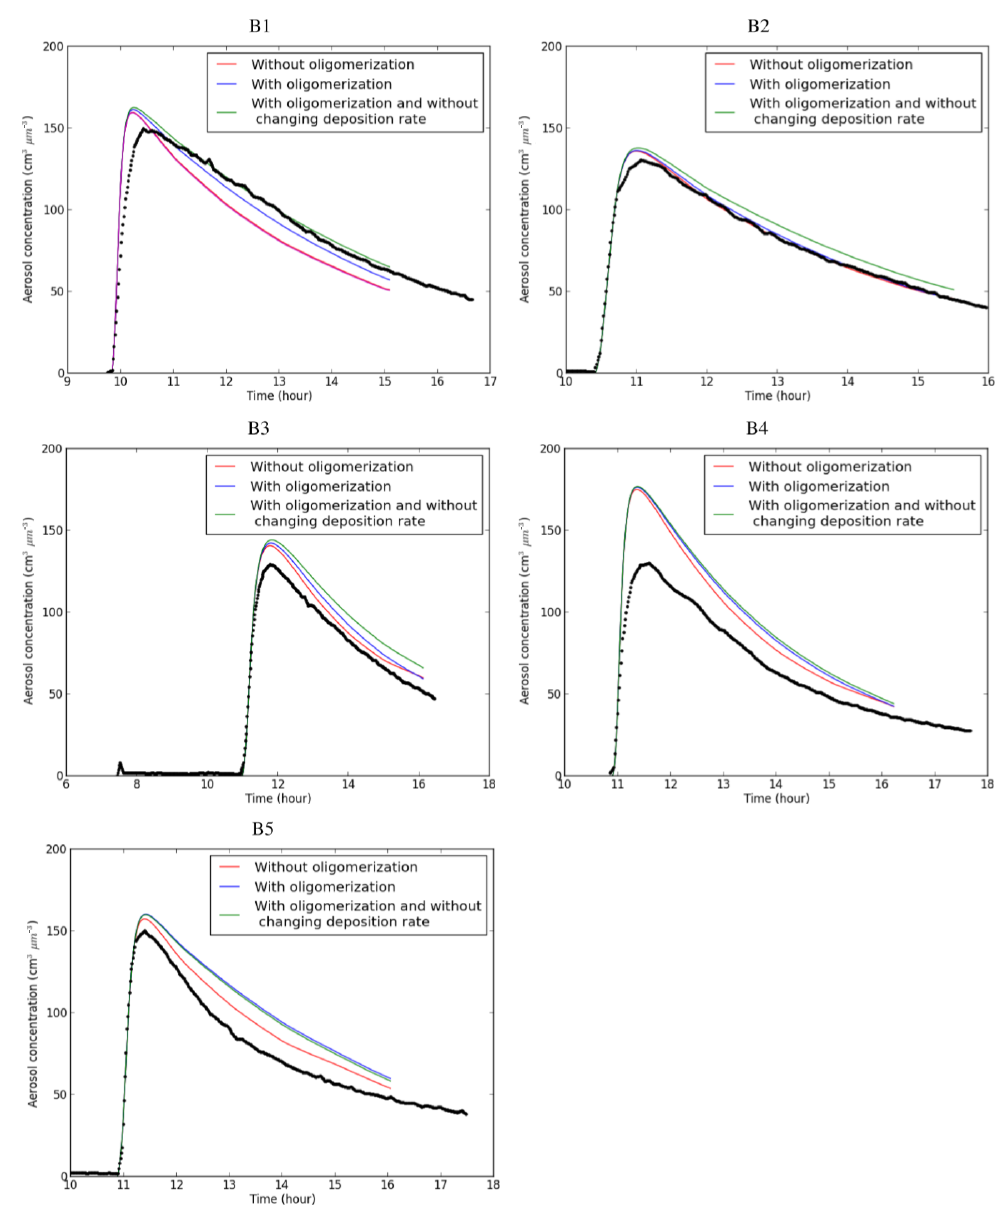
Figure 3. Aerosol concentration formation for the biogenic experiments without SO 2 . Black lines correspond to SMPS